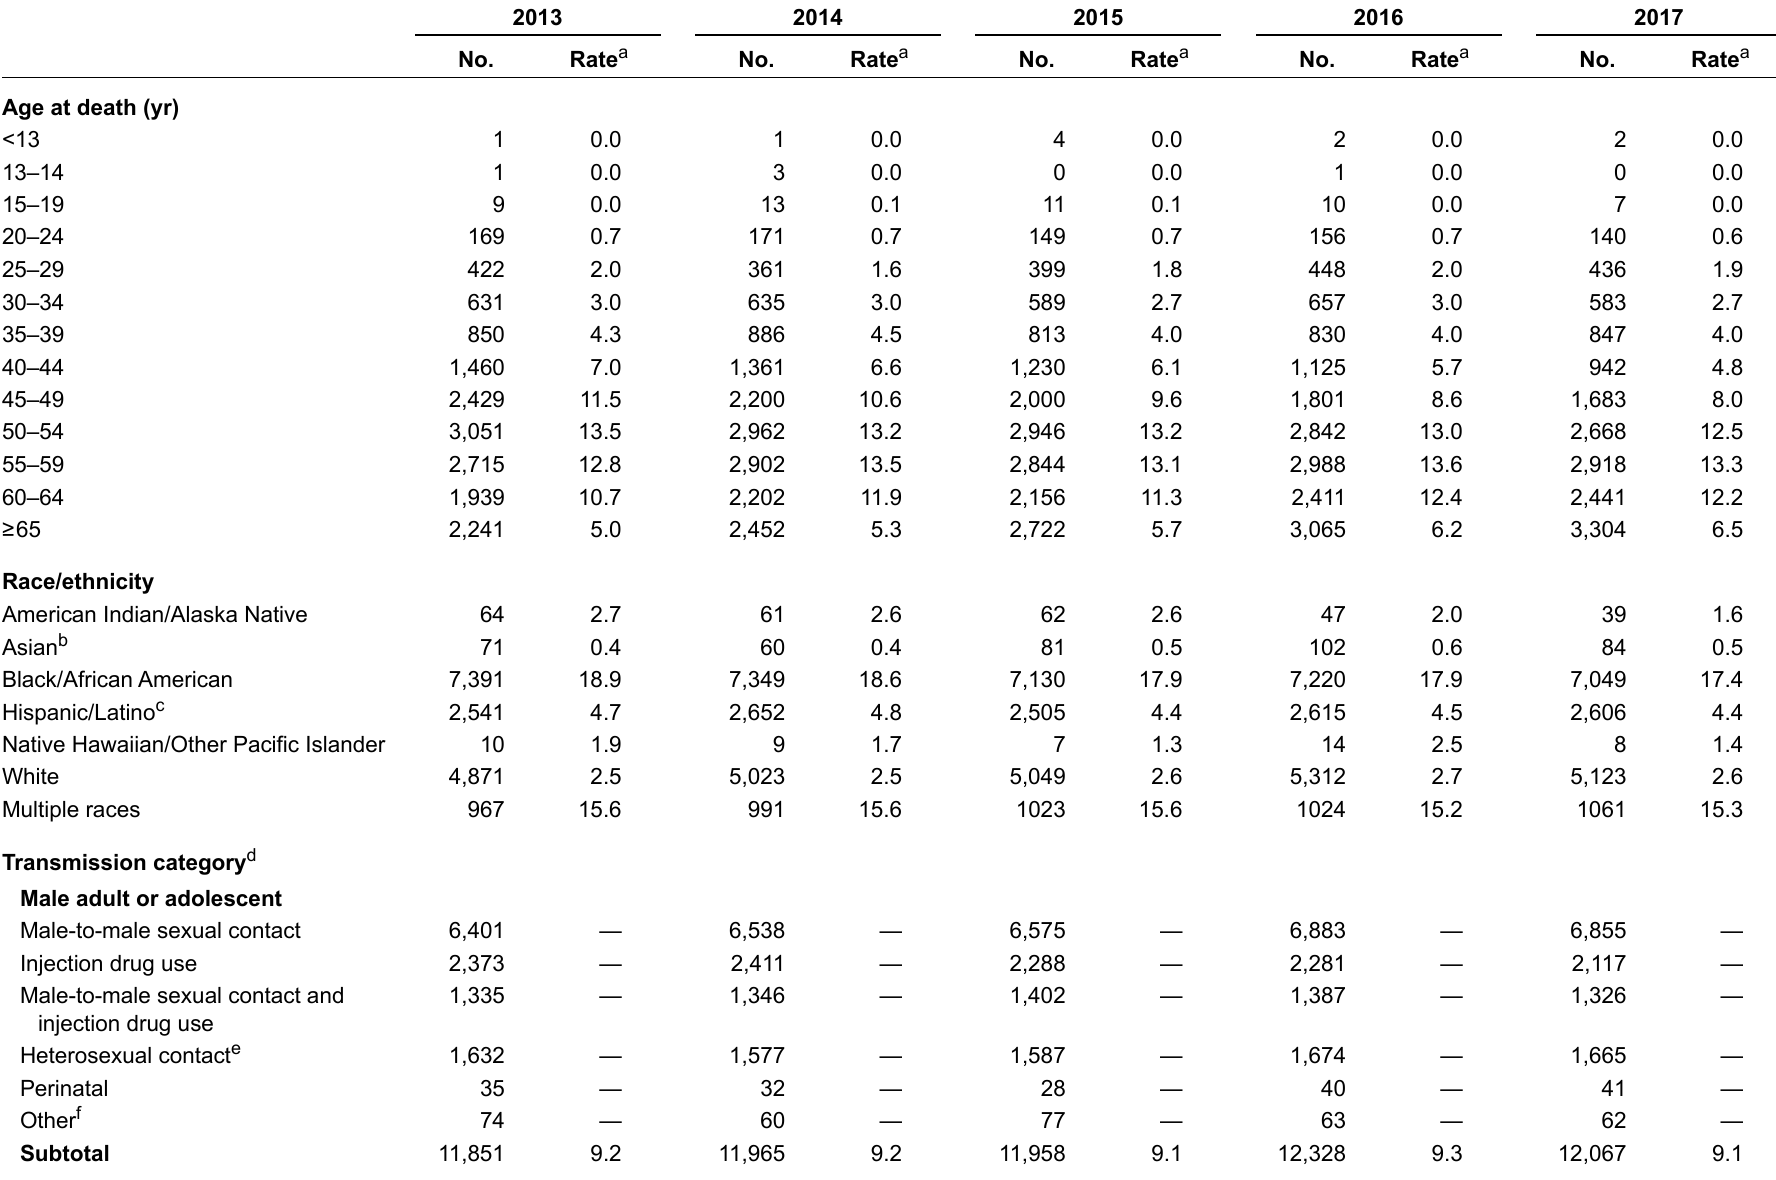
Table 18a. Deaths of persons with diagnosed HIV infection, by year of death and selected characteristics, 2013–2017—United States 2013 2014 No. Rate a No. Rate a No. Rate a No. Rate a No. Rate